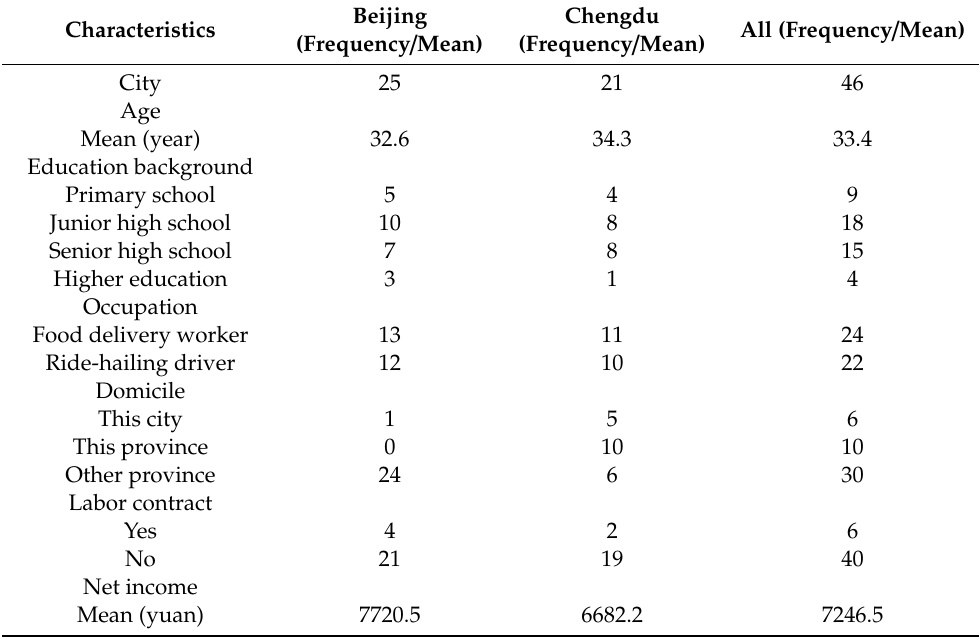
Table 1. Characteristics of platform worker participants in Beijing and Chengdu ( N = 46). Beijing Chengdu All (Frequency / Mean) Characteristics (Frequency / Mean) (Frequency / Mean) City